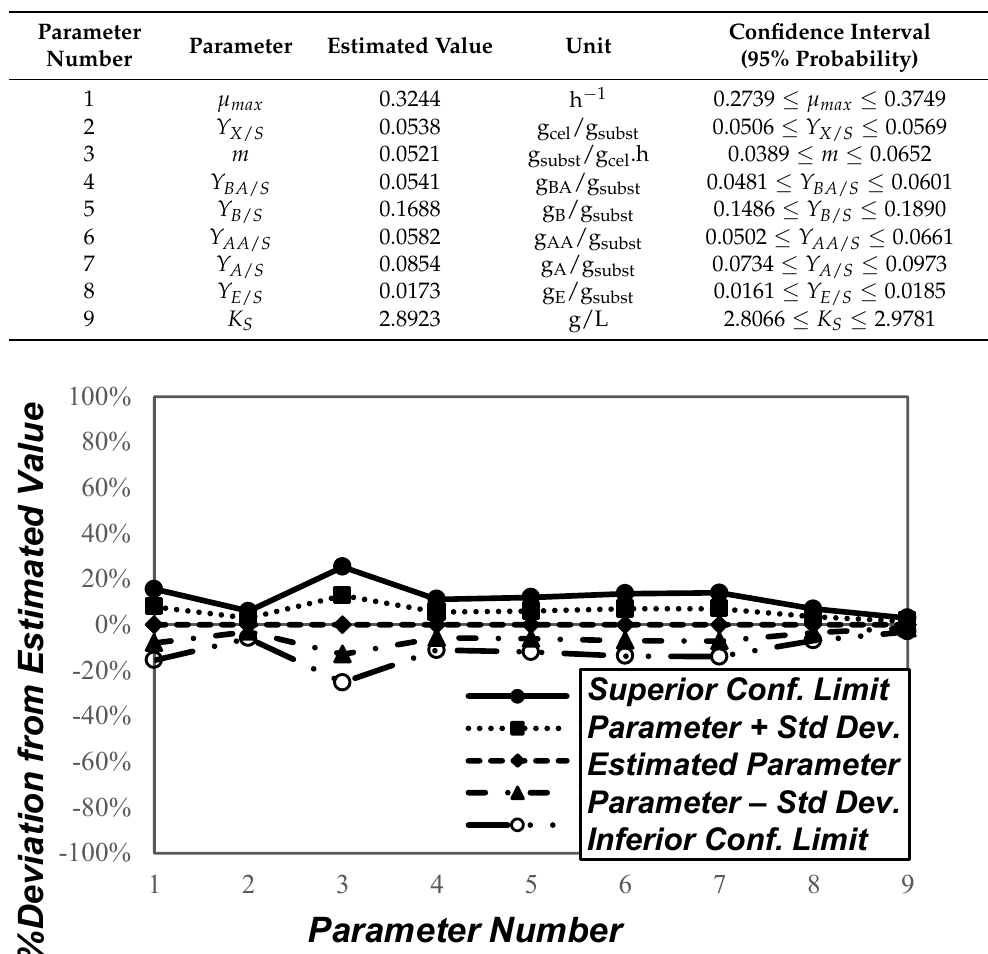
Table 5. Parameter estimation and 95% probability confidence intervals of correct parameters for the Reduced-Model with 9 parameters.